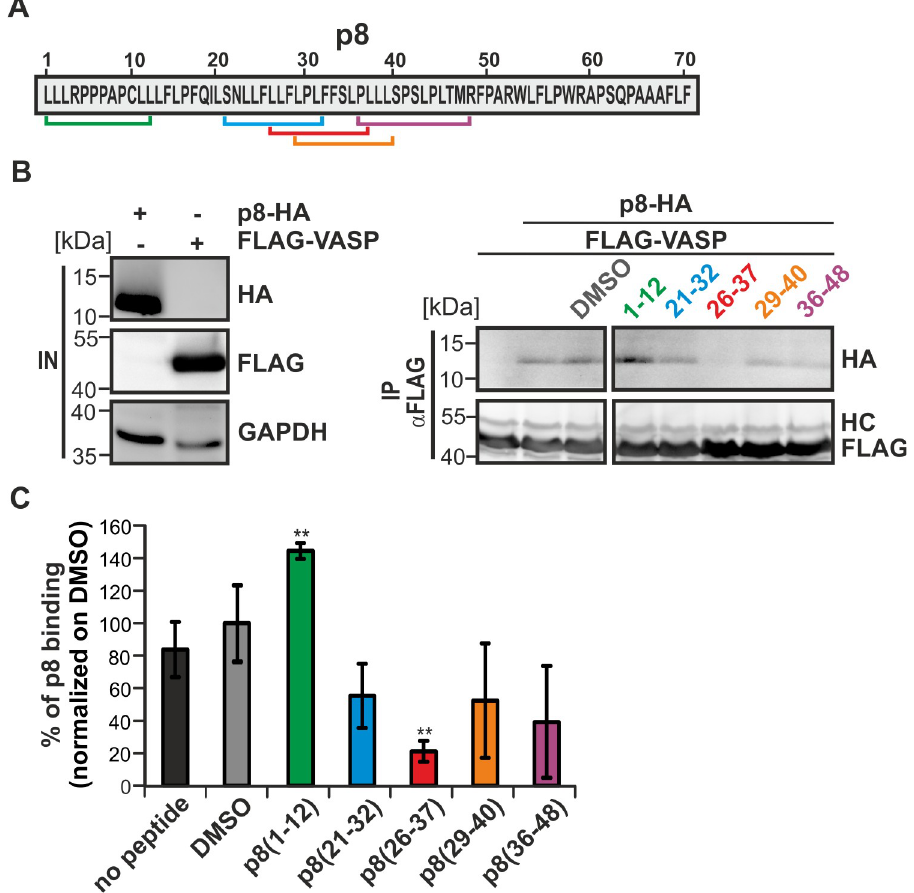
Fig 3. p8-mimicking peptides reduce the interaction between p8 and VASP. (A) Amino acid sequence of p8. Bars indicate location of competitive p8 inhibitory peptides. (B) p8-HA and FLAG-VASP were expressed individually in 293T cells. After 48 h, cells were lysed and 10% of the cell lysate were taken as input (IN). The remaining lysates were co-incubated with the peptides shown in (A) , or with the solvent control DMSO for 1.5 h at 20˚C. Thereafter, lysates were mixed for 1.5 h, and co-precipitations (anti-FLAG) were performed (IP). Representative immunoblots are shown. The blot (IP) was cut due to technical reasons. HC, heavy chain. (C) The impact of p8-mimicking peptides on binding of p8-HA after precipitation of FLAG-VASP was assessed by densitometry. DMSO was set as 100%. The means of four independent experiments ± SE were compared to DMSO-treated cells using Student’s t-test. �� indicates p <